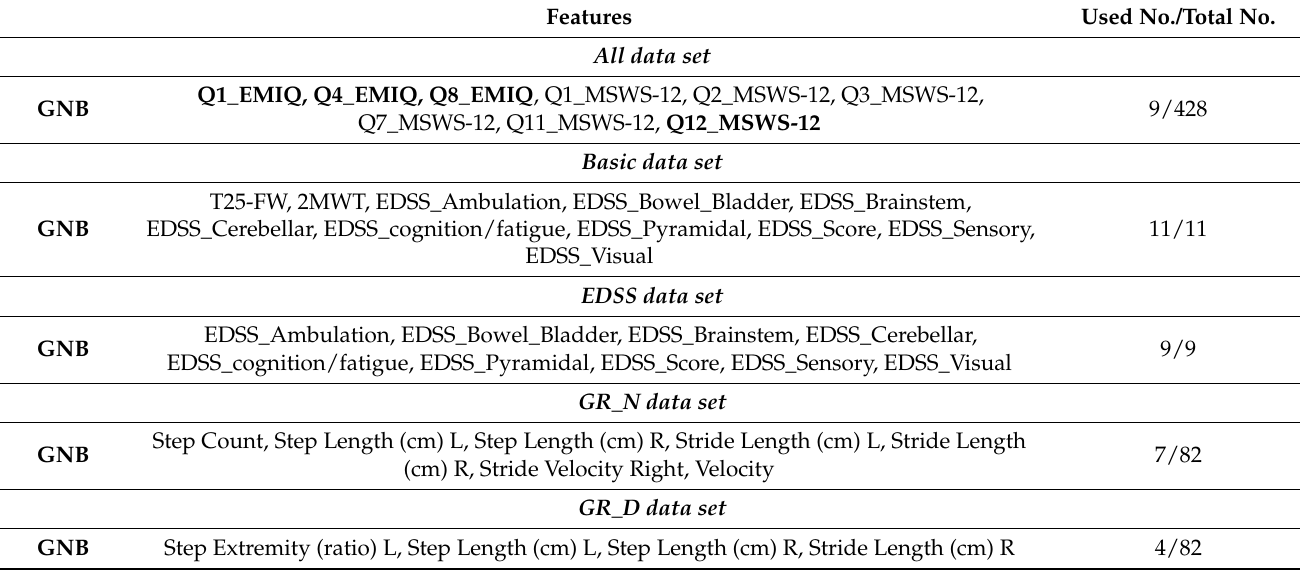
Table 5. The final feature subsets achieve the best performance according to Table 4. The features, highlighted in bold, were chosen as the most relevant features in both the All data set and the individual data sets. The unit of each gait parameter is shown in parentheses. The parameters have been recorded and merged for the left and right sides (L/R). The parameters are presented as mean [mean] or standard deviation [std].